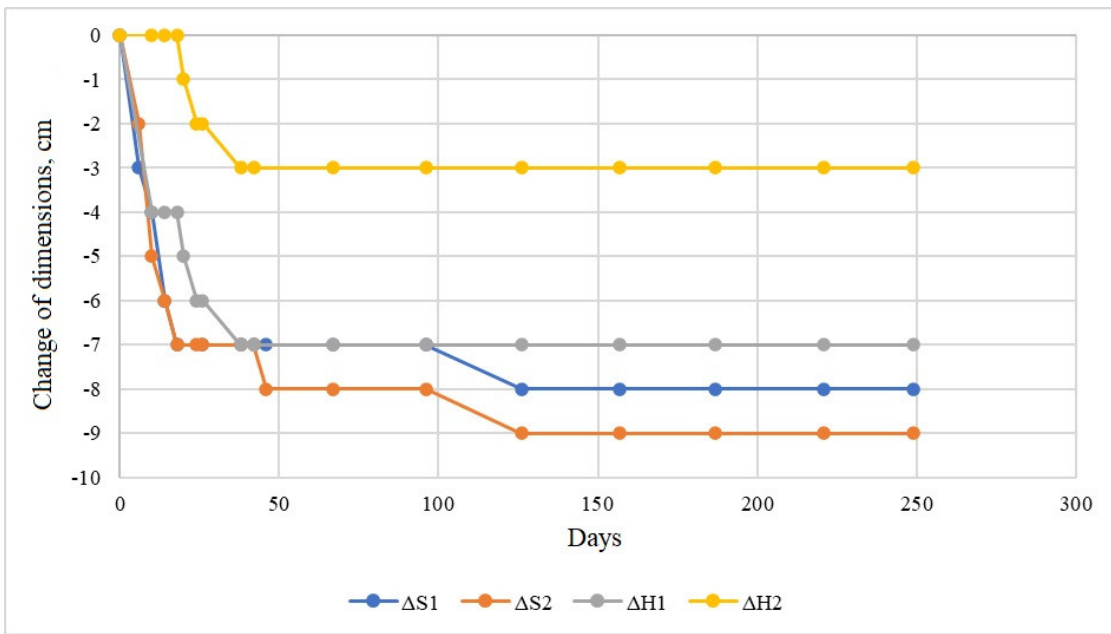
Figure A5. Change of the roadway dimensions—convergence control station no. 1.